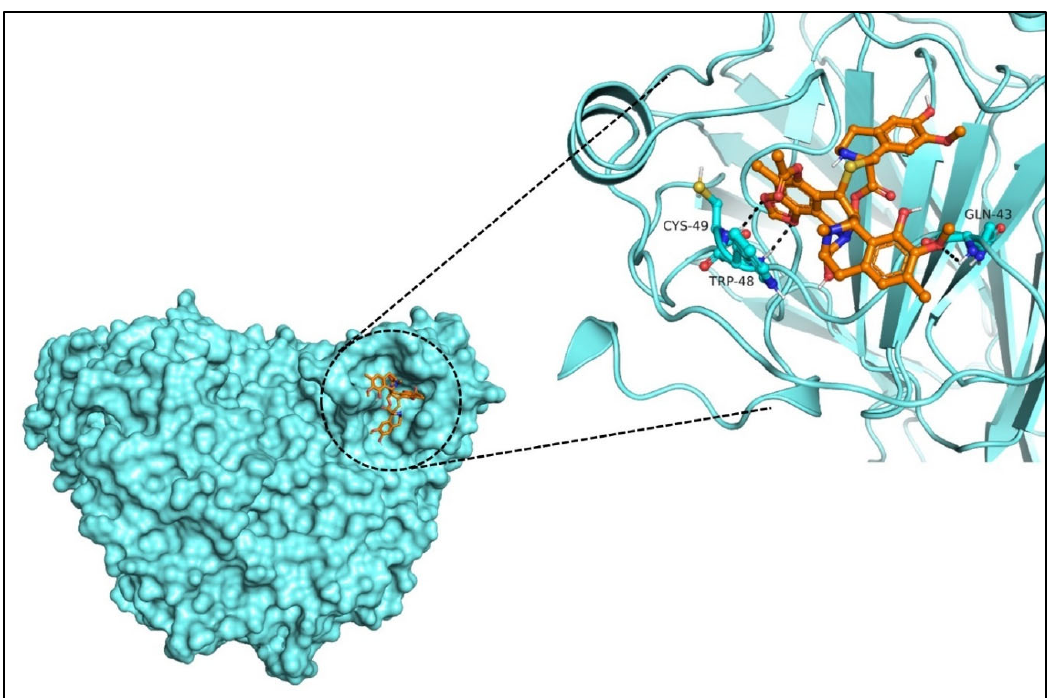
Figure 7. Best docked pose of most potent hit Trabectedin with Alpha Glucosidase in surface form (left image) and ligand–receptor interactions in cartoon form (right image).